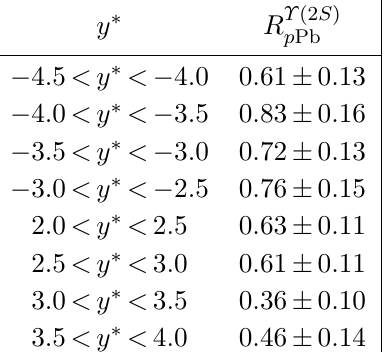
, in p Pb and Pb p as a function of y (cid:3) integrated p Pb